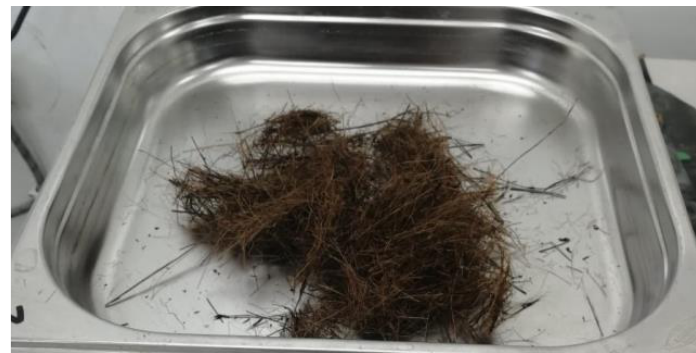
Figure 4. SDPMFs in SSD condition. Table 3. Physical properties of SDPMF.